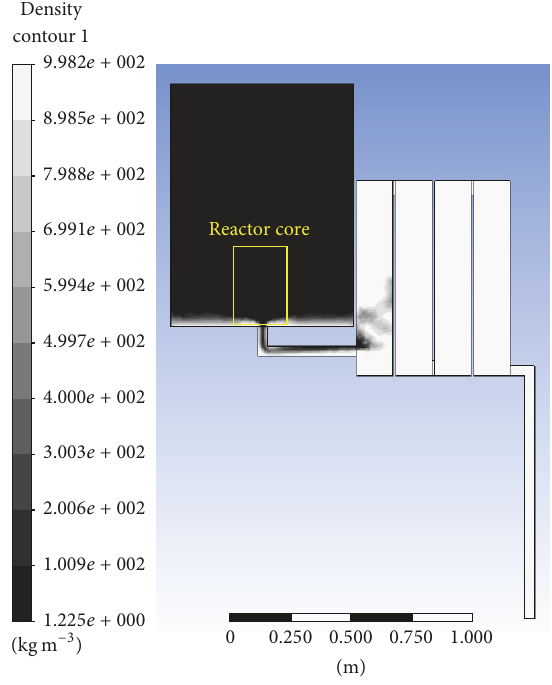
Figure 12: Simulation result of siphon